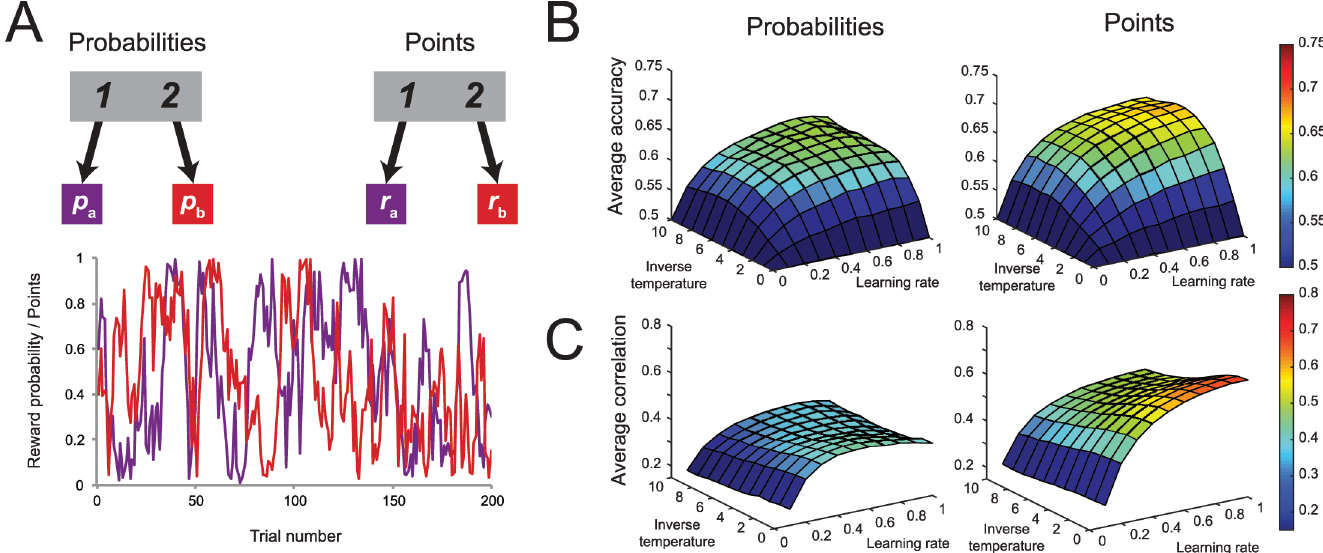
Fig 10. The influence of the type of reward distribution (points vs probabilities) on choice accuracy. (A) We ran simulations of RL agents on two different two-armed bandit tasks. For one, the reward distributions indicate the reward probability associated with each action. The other task does not include binomial noise, but instead the actions pay off rewards that are directly proportional to its value in the reward distribution. (B) Agents show greater accuracy in choosing the highest-value action on the task the task where the two-armed bandit pays off points instead of affording a probability to win a reward, especially when both the inverse temperature and learning rate were high. (C) The Q-values of each action shows stronger correlations with their objective reward value in the task where the two-armed bandit payed off points instead of affording a probability to win a reward.